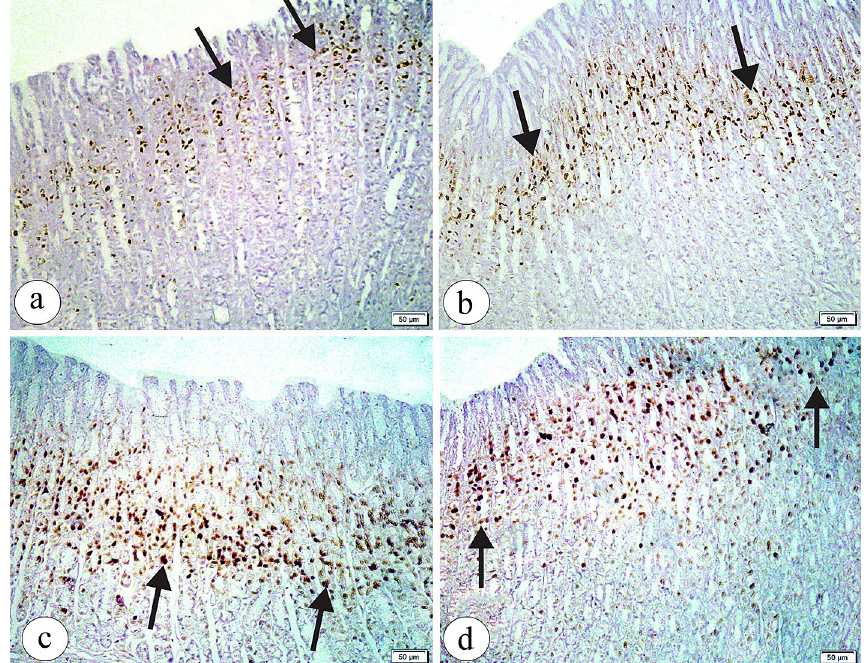
Figure 5. The photomicrographs of the sections in the glandular portion of the stomach in ( a ) the group Ӏ showing a positive PCNA immunoexpression (arrow) in the gastric cells’ nuclei of the upper gastric glands. ( b ) the group ӀӀ showing a positive PCNA immunoexpression(arrow) more or less than the group Ӏ . ( c ) the group ӀӀӀ showing an apparently increased positive PCNA immunoexpression (arrow)in the gastric cells’ nuclei extending into the basal part of the gastric glands as compared to the group Ӏ ( d ) the group Ӏ V showing an apparent decrease in the positive PCNA immunoexpression (arrow) in the gastric cells’ nuclei as compared to the group ӀӀӀ . (PCNA immunohistochemical staining × 200, Scale bar = 50 µm).